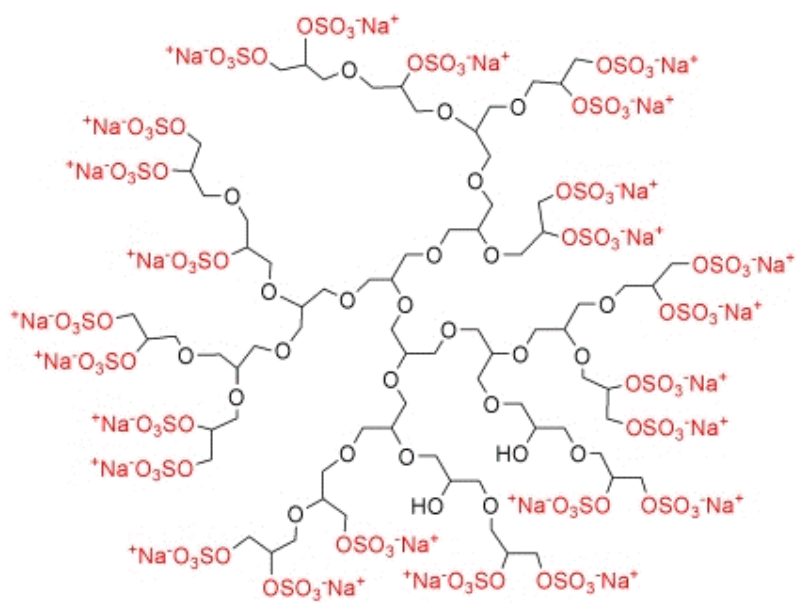
FIGURE 6. Representative structure of the PEO-sulfated dendrimers used in Dernedde et al.[53]. (© PNAS, reproduced with permission .